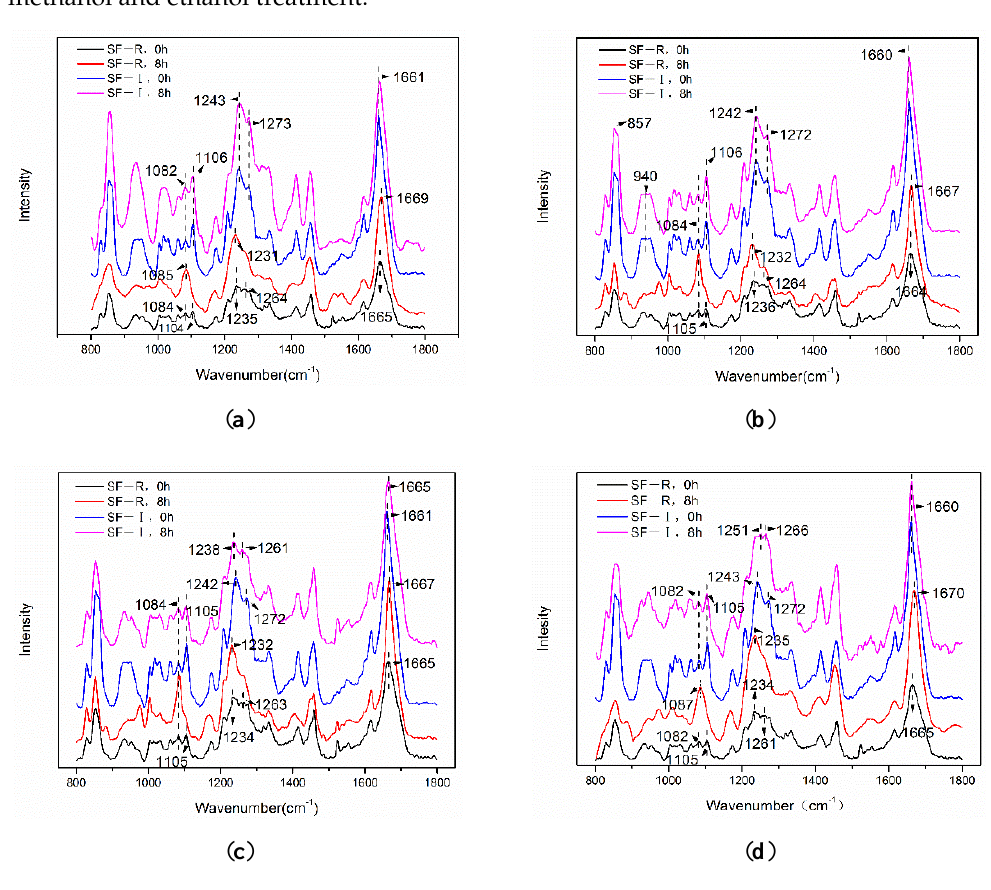
Figure 4. Raman spectra of silk fibroin materials (SF-I and SF-R) before and after alcohol treatments: ( a ) 75% methanol, ( b ) 90% methanol, ( c ) 75% ethanol, ( d ) 90% ethanol.